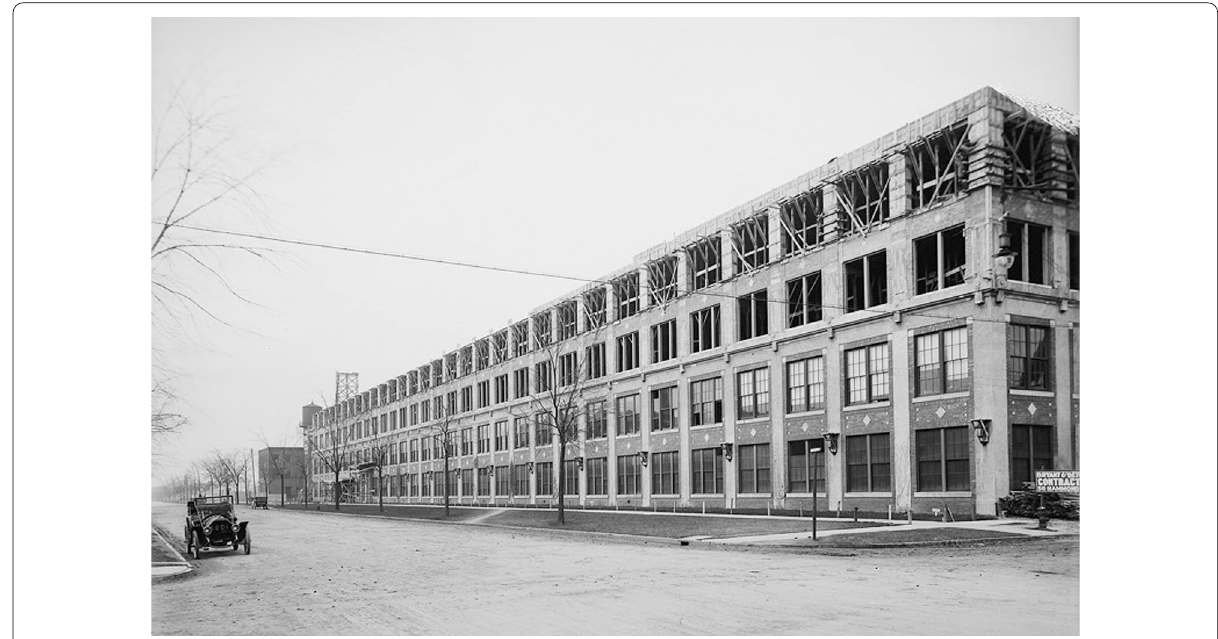
Fig. 1 Packard Automobile Plant, Detroit, Michigan. Architect: Albert Kahn (Photo by unknown